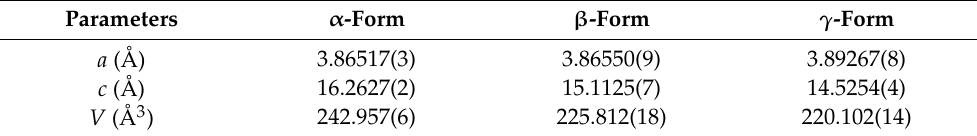
Table 1. Lattice parameters ( a , c ) and unit cell volume ( V ) for the studied forms of HCa 2 Nb 3 O 10 · y H 2 O.